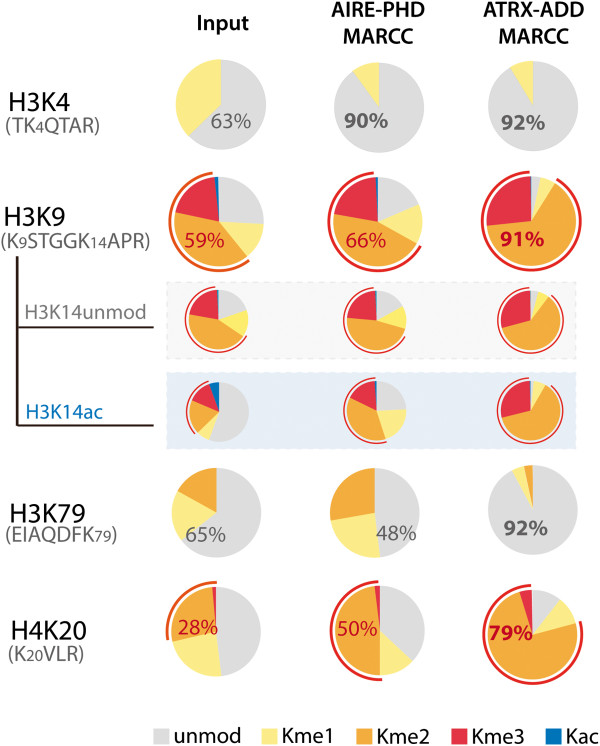
A unique nucleosomal PTM combination captured by ATRX-ADD MARCC. Relative amounts of different PTM states for selected histone peptide fragments from MARCC-enriched chromatin determined by qMS. Peptide sequence and modified lysine is labeled in the chart. Different PTM states for the same peptide sequence are represented by different colors. Relative quantity of the dominant state is labeled in the pie chart with unmodified state colored in gray and dimethylated or trimethylated state colored in red (red encircling lines mark the pooled dimethylation and trimethylation states). A high level of near stoichiometric enrichment of 4 PTM states (H3K4unmod, H3K9me2/3, H3K79unmod and H4K20me2/3) was identified from MARCC with ATRX-ADD. For AIRE-PHD MARCC, H3K4unmod but not the other three PTM states was enriched to 90%.